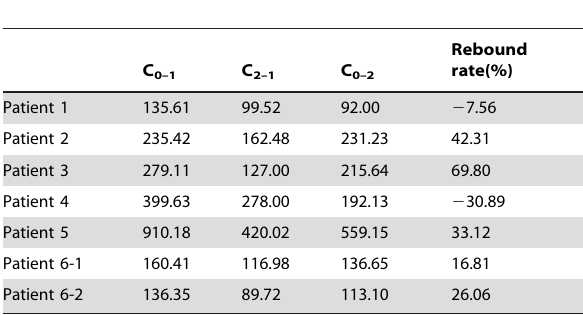
Table 3. The plasma PQ concentrations of patients receiving repeated